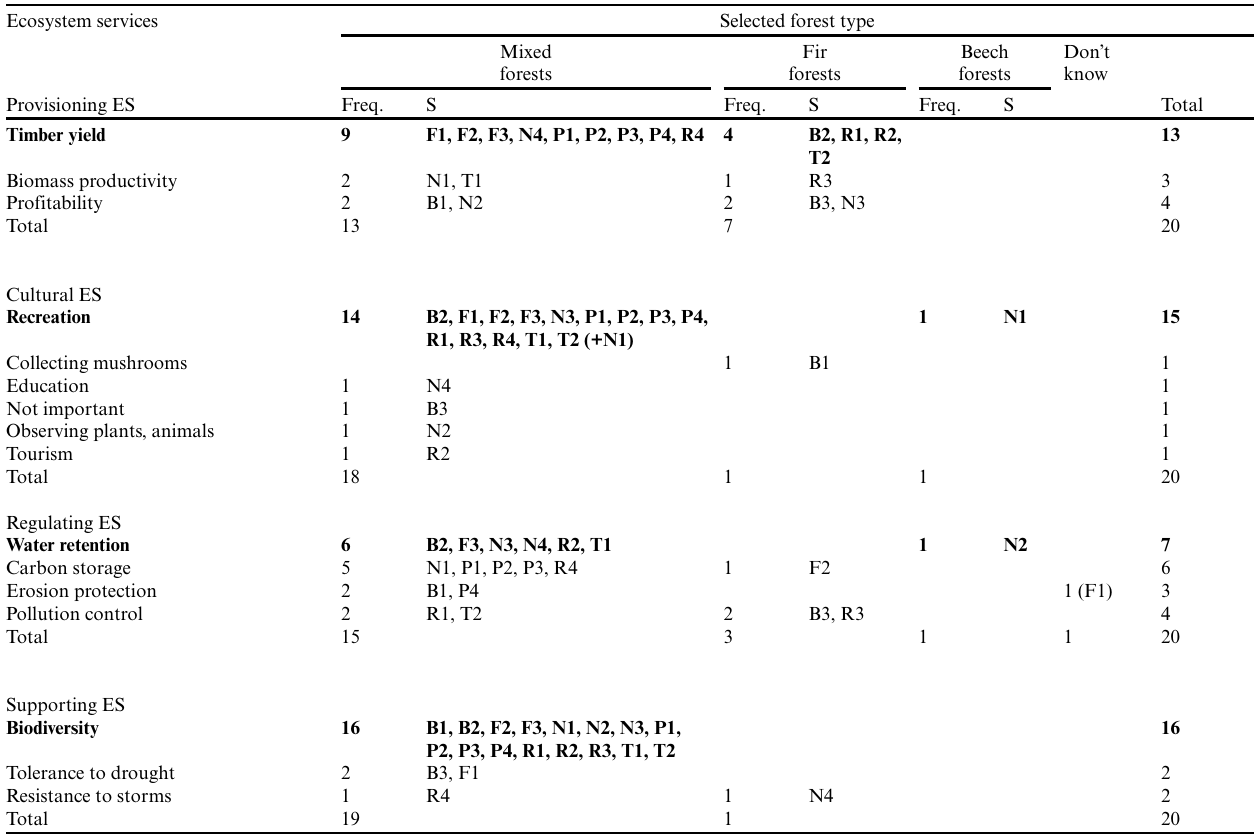
Table 4 . Frequency of responses on the preferred forest type for the provision of the prioritized ecosystem services (ES). Ecosystem services Selected forest